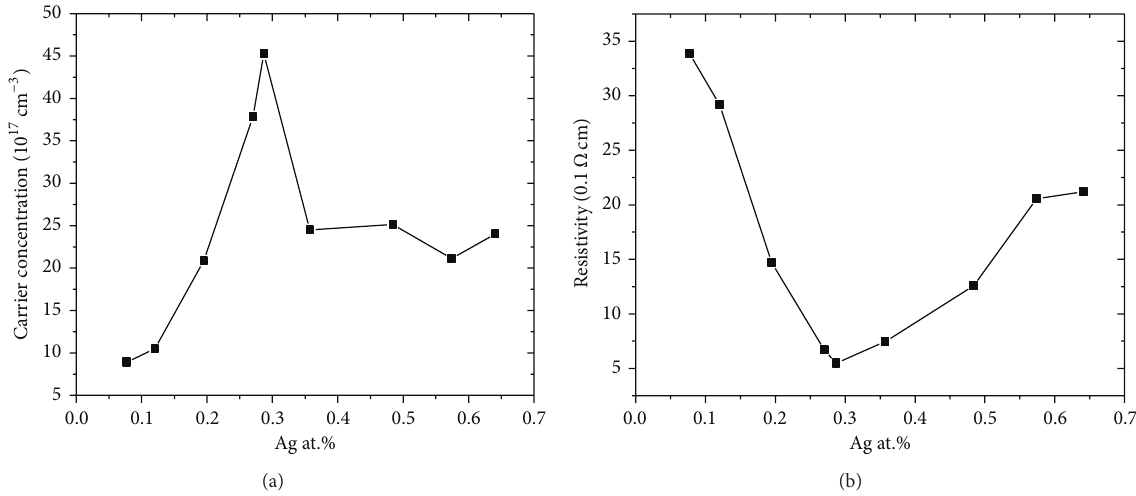
Figure 5: The variation of carrier concentration (a) and resistivity (b) with the Ag